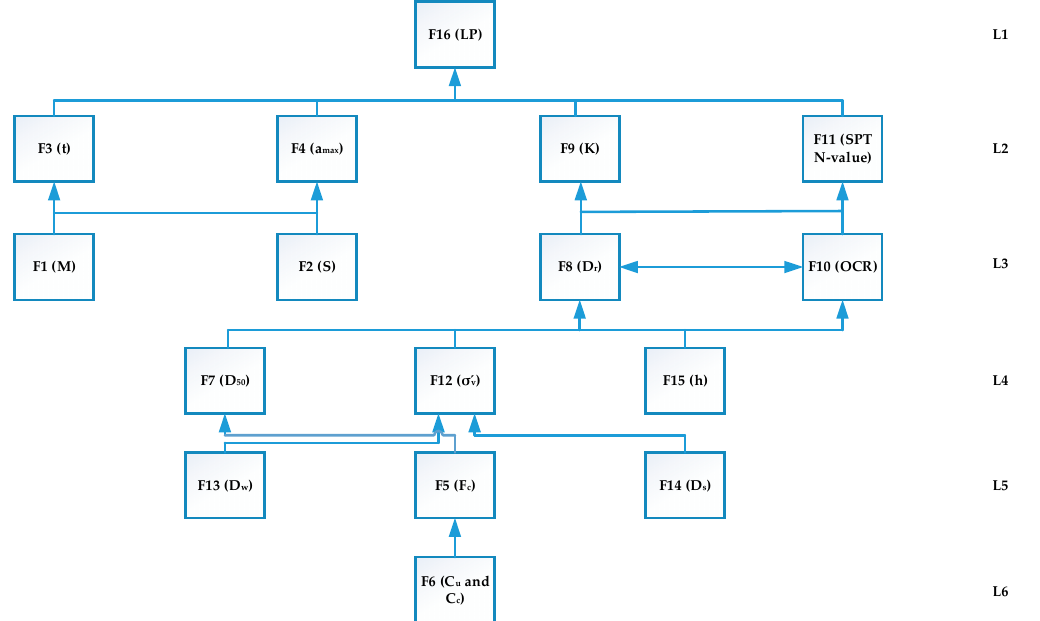
Figure 4. Model depicting the relationships between soil liquefaction factors based on ISM.